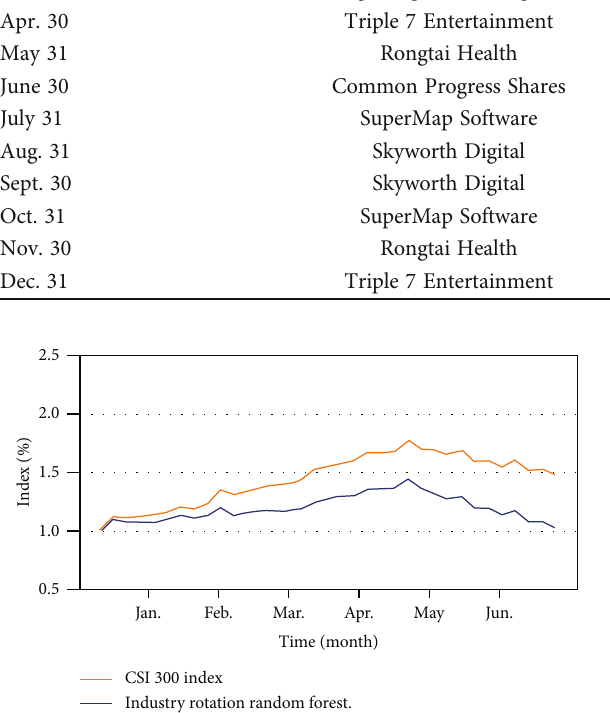
Figure 4: Random forest investment strategy versus market